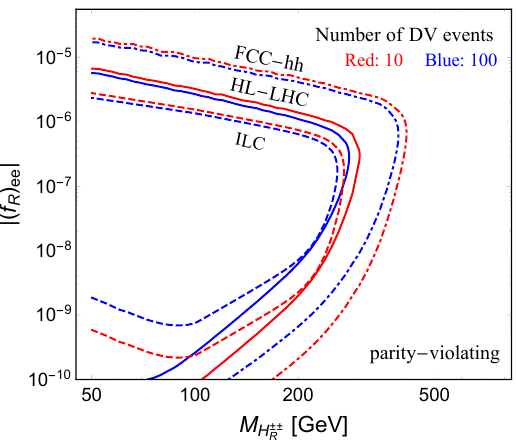
Figure 24 . DV prospects from the decay of H (cid:6)(cid:6) ! e (cid:6) e (cid:6) in the parity-violating LRSM, at the R HL-LHC 14 TeV with an integrated luminosity of 3000 fb (cid:0) 1 (solid contours), the 100 TeV FCC-hh with a luminosity of 30 ab (cid:0) 1 (dot-dashed contours) and ILC 1 TeV with 1 ab (cid:0) 1 (dashed contours). The red and blue contours respectively correspond to 10 and 100 DV events, as functions of M H (cid:6)(cid:6) R and the Yukawa coupling j ( f R ) ee j